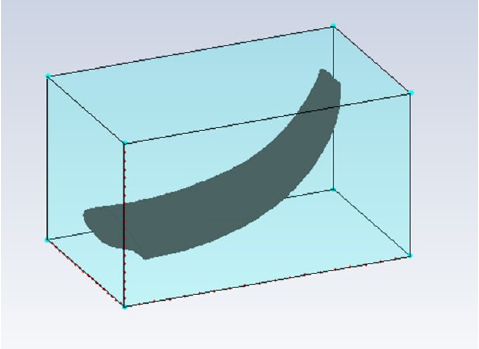
Figure 3. Shape optimization region definition.